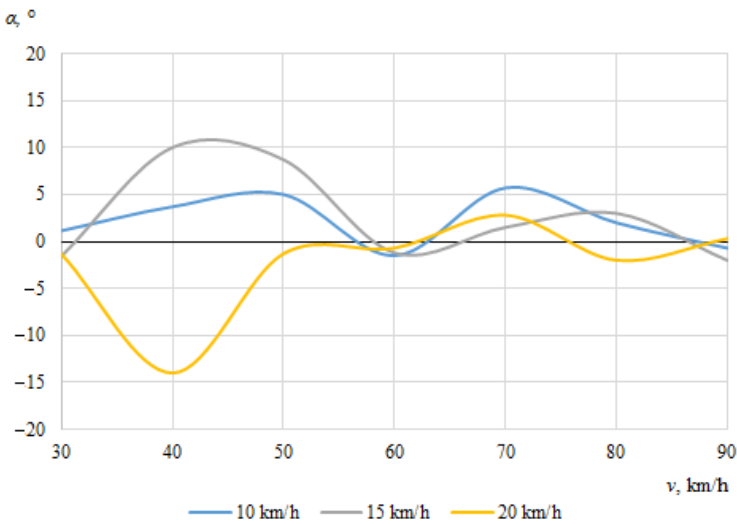
Figure 8. Bicycle throwing angle (impact angle 0°).